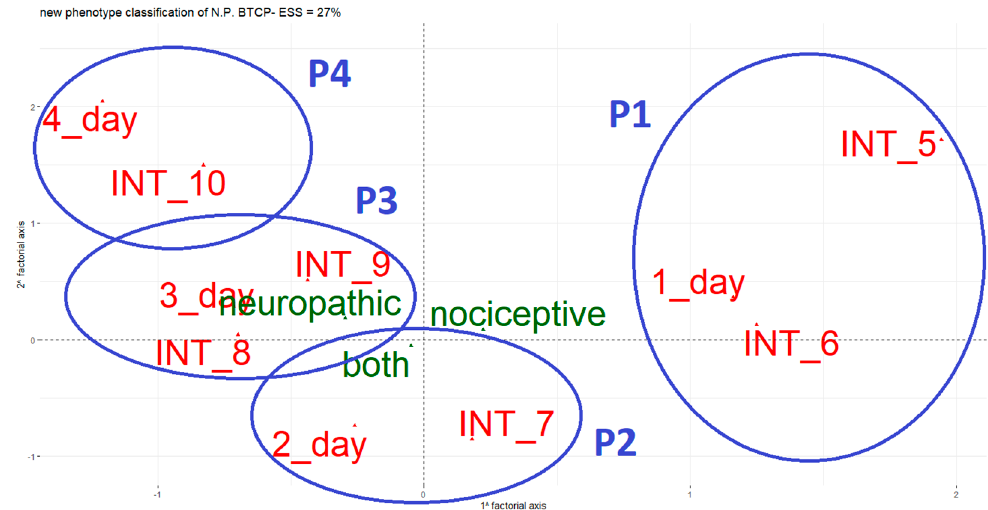
Figure 2. Multiple correspondence analysis (MCA plot). Identification of 4 groups (phenotypes, P) of breakthrough cancer pain (BTcP) from P1 to P4 by combining the variables BTcP intensity (INT) score (INT_5; INT_6; INT_7; INT_8; INT_9; INT_10) and number of BTcP episodes per day (1_day; 2_day; 3_day; 4_day) with the categorical variable BTcP type (nociceptive, neuropathic, both).